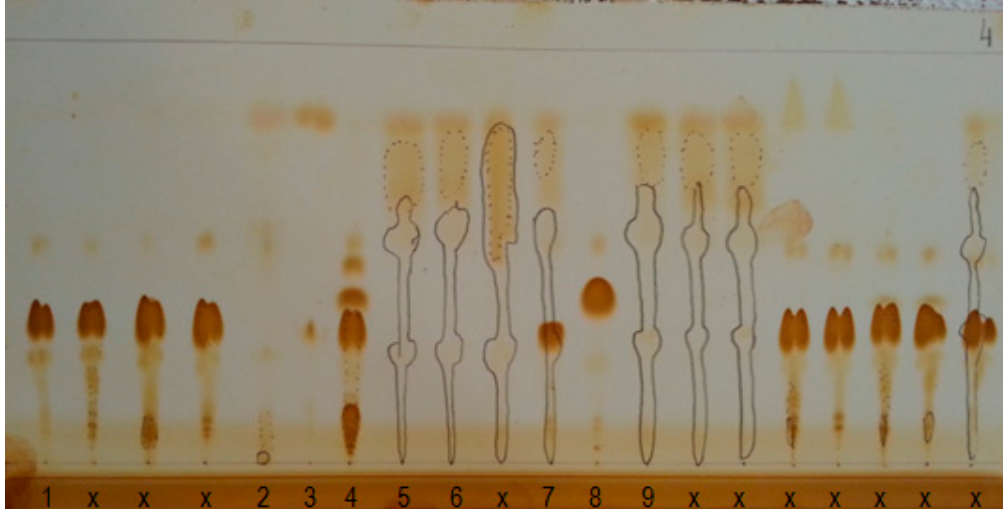
Figure 8. Chromatogram after fourth stage of plate visualization, i.e., after iodine vapor exposure. The sample type is presented in Table 1, please refer; x—other commercially available lubricating oils .